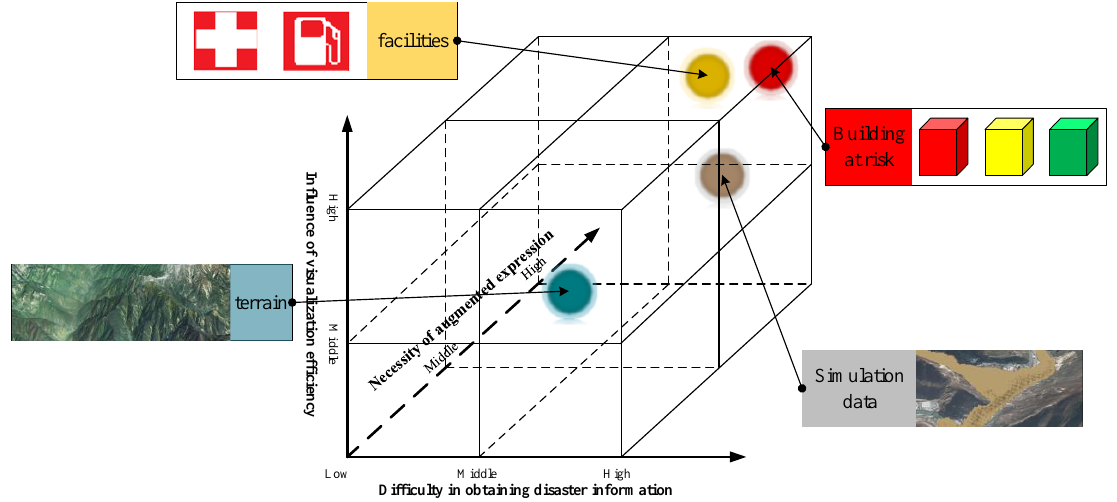
Figure 3. Cube model of self-explanatory symbols and photorealistic scene cooperation.